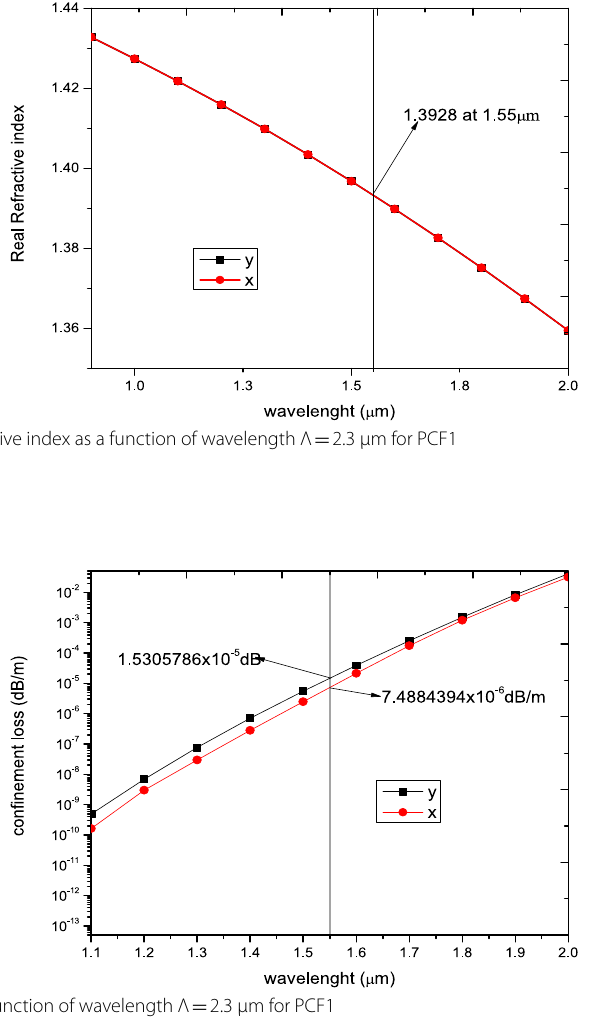
2.3 µm for PCF1 =